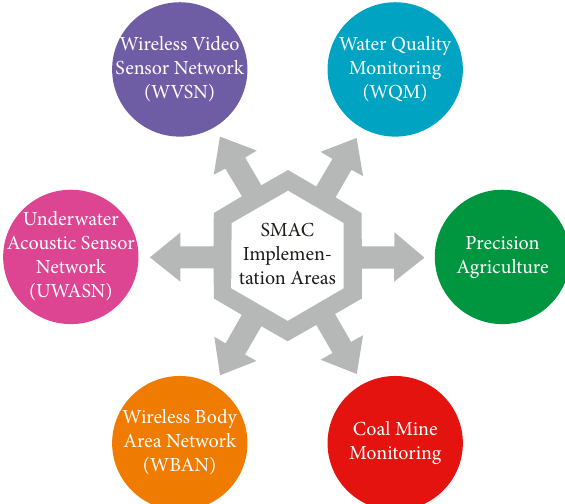
Figure 11: Distribution of performance metrics used in proposed SMAC